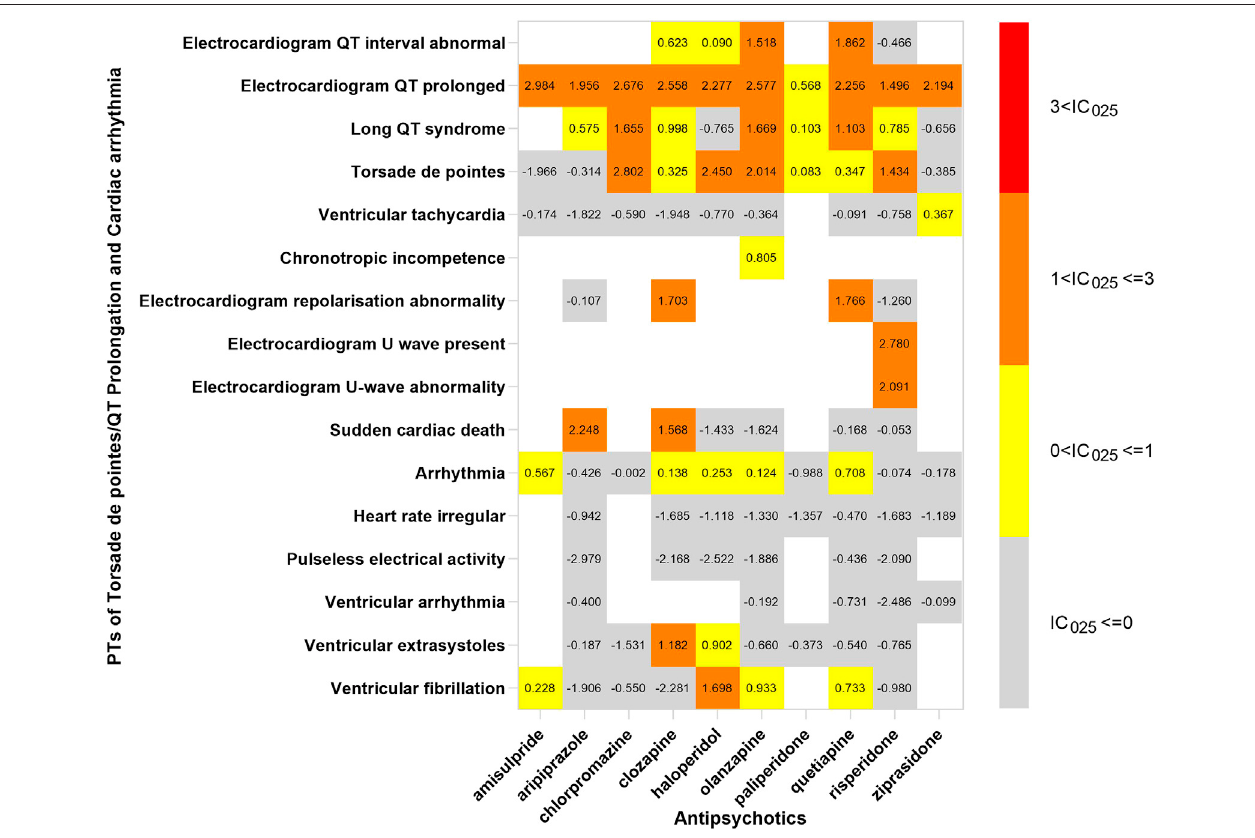
FIGURE 6 | The spectrum of Torsade de pointes/QT prolongation and cardiac arrhythmia induced by various APs. PT: preferred term; IC 025 : the lower end of the 95% con fi dence interval of theinformation component. The numbers in blocks represent the value of IC 025 ofeach combination oftarget antipsychotic and PT. Torsade de pointes and ventricular tachycardia are the common PTs both in Torsade de pointes/QT prolongation and cardiac arrhythmia.